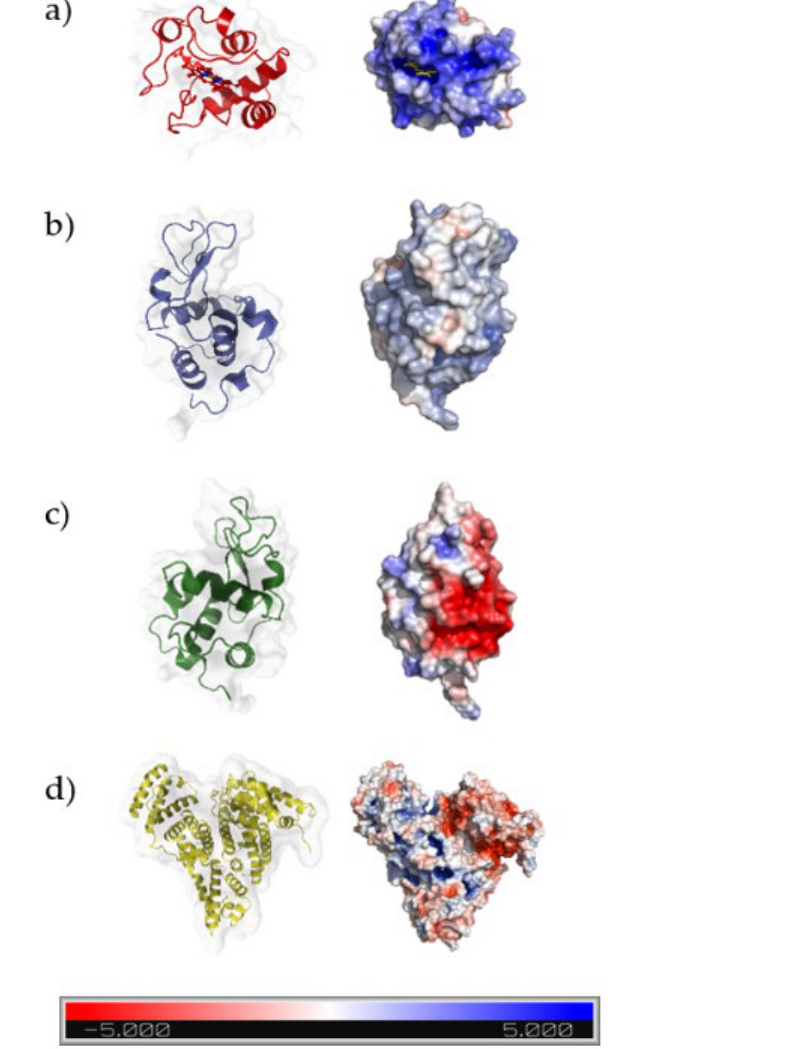
Figure 11. Surface representation, with coloring based on the electrostatic potential of ( a ) Cyt C from horse heart (PDB ID 1HRC; [81]), ( b ) Lys from chicken egg white (PDB ID 5LYZ; [82]), ( c ) α -LA from bovine milk (PDB ID 1F6S; [83]) and ( d ) BSA (PDB ID 4F5S; [84]). Electrostatic potentials were calculated using APBS [85], and images were prepared using Pymol [86].